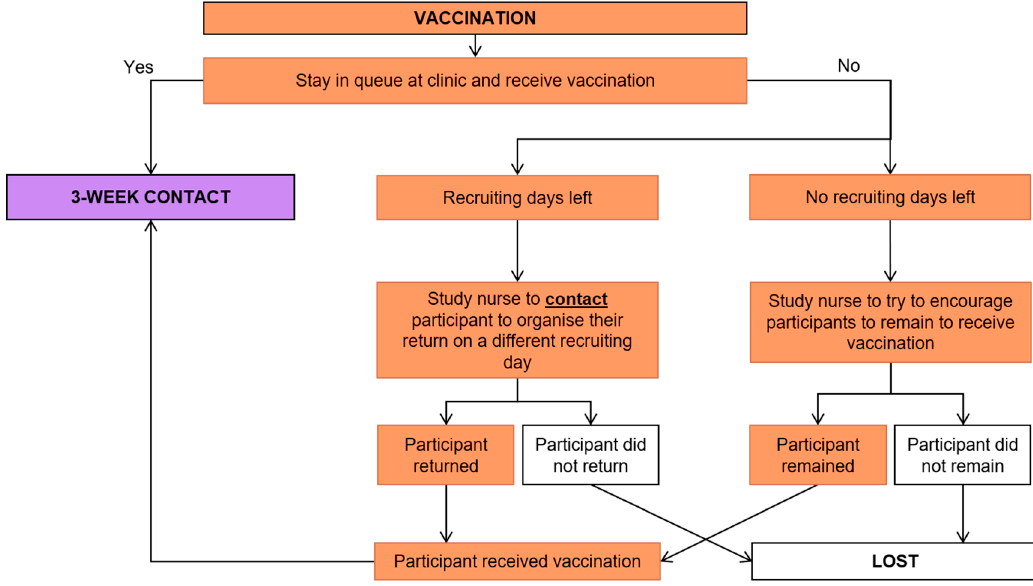
Figure 5. Vaccination stage flow chart.